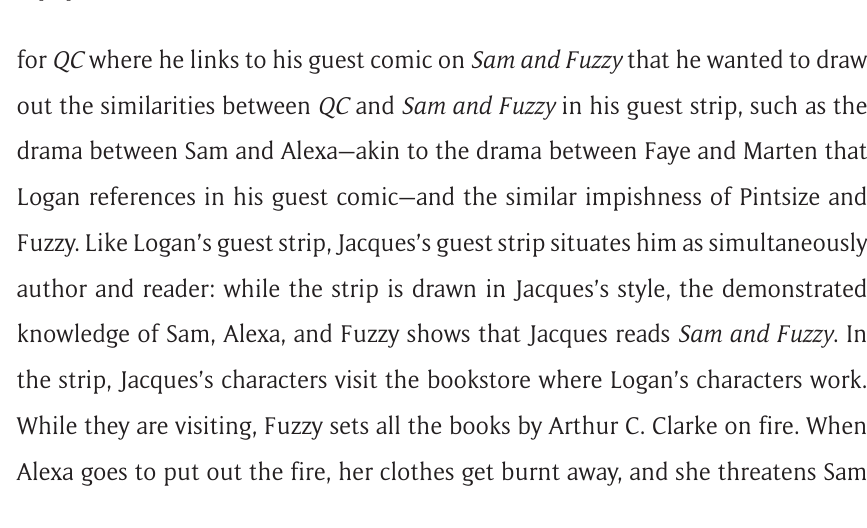
able Content . 19 July. Available at https://www.questionablecontent.net/view.